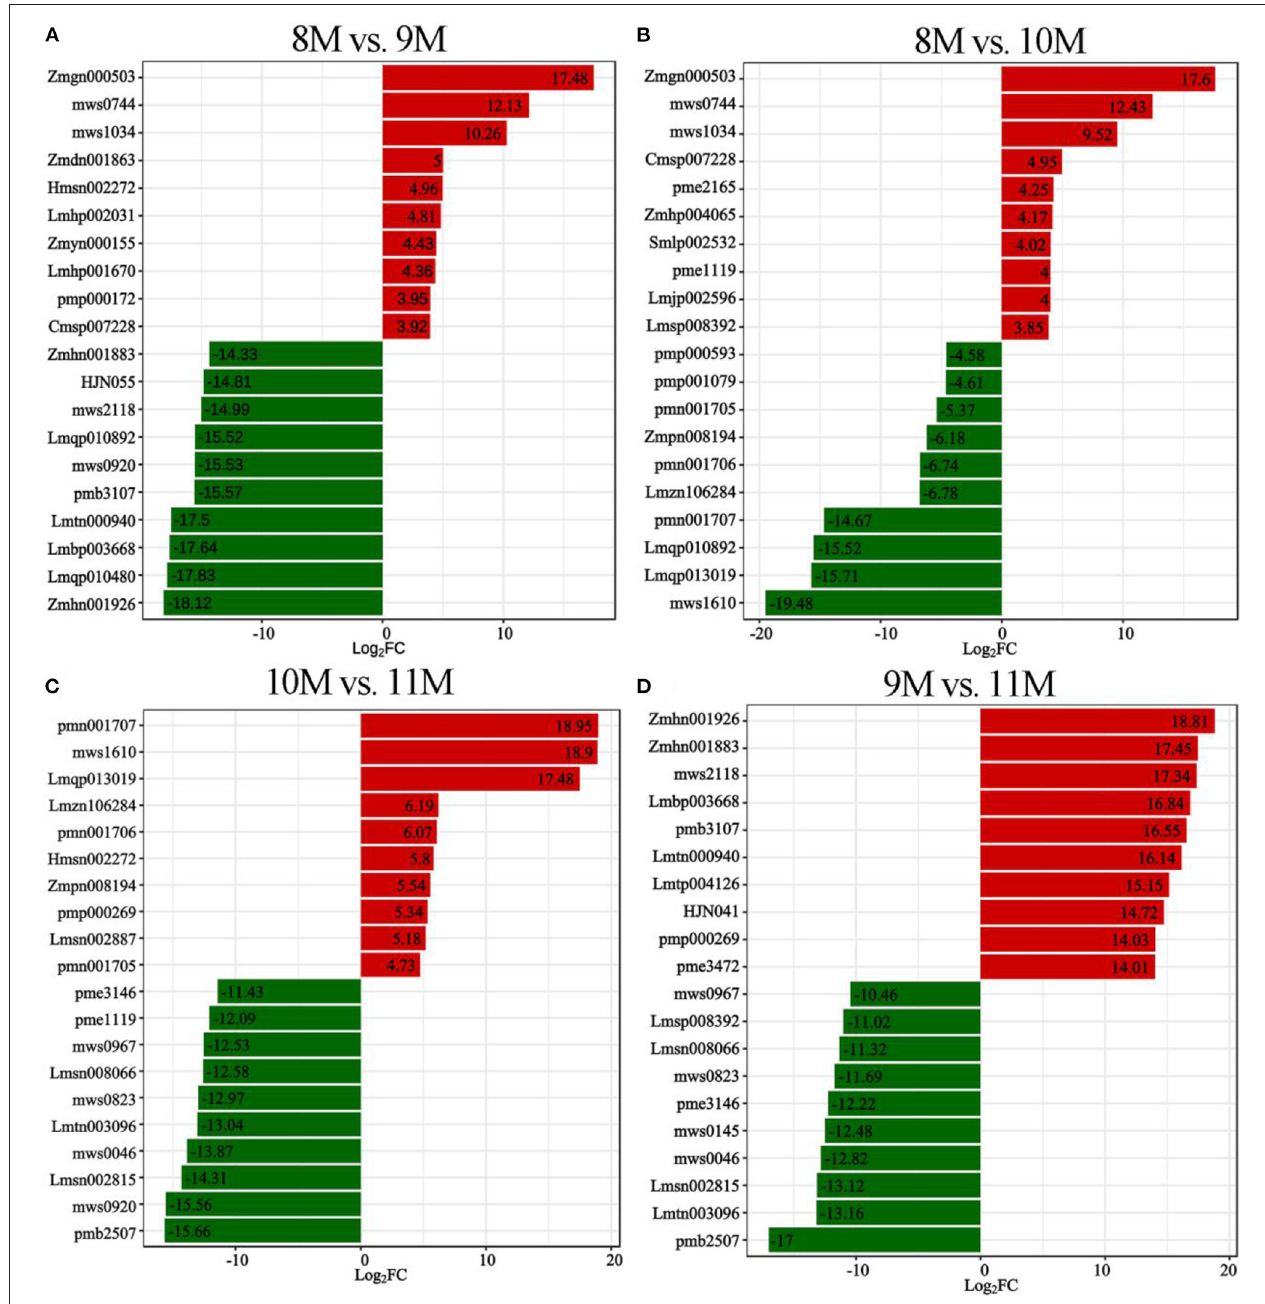
FIGURE 3 | Differential metabolite expression analysis. Top 20-fold changes in DAMs in the 8M_vs_9M (A) , 8M_vs_10M (B) , 10M_vs_11M (C) , and 9M_vs_11M (D) groups. X-axis represents the log 2 FC of DAMs, and Y-axis represents the different DAMs. Red and green represent up- and down-regulated DAMs, respectively.